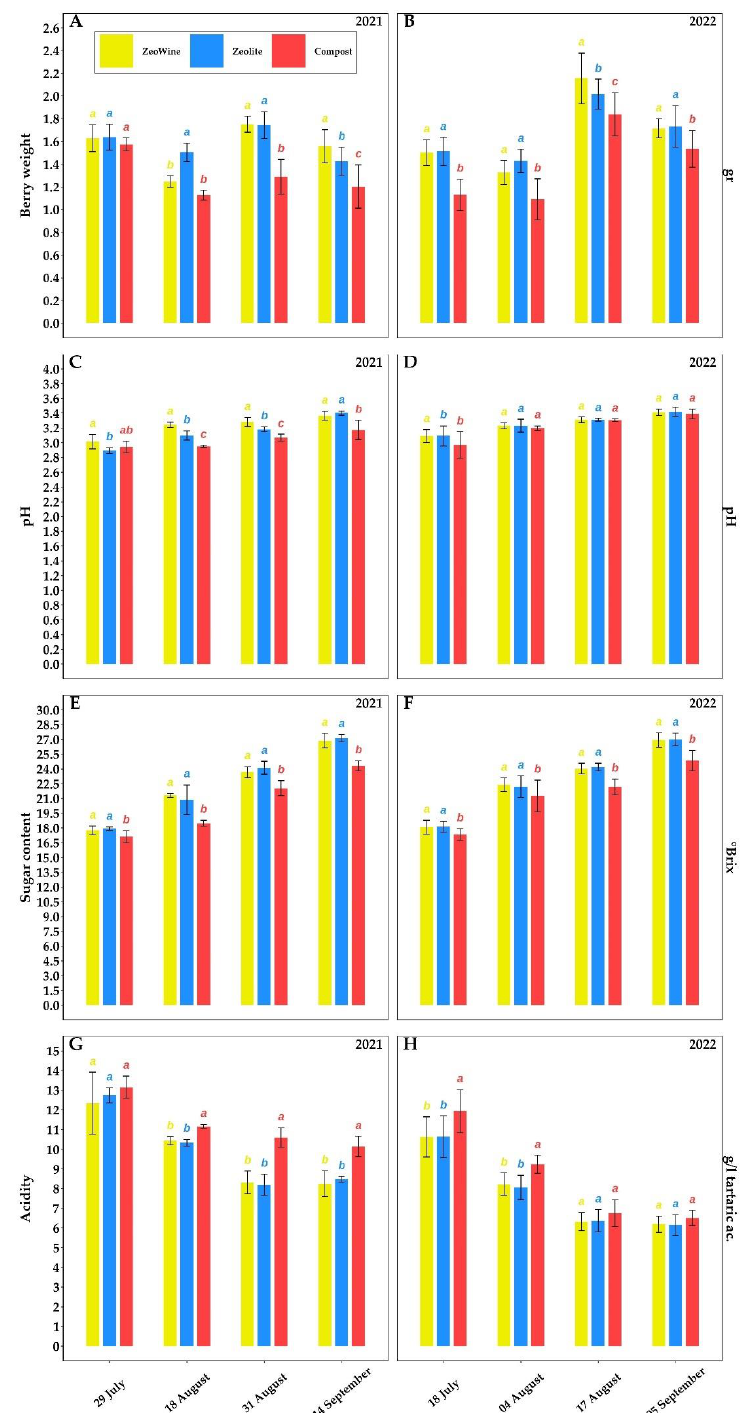
Figure 6. Technological maturity. Sugar content ( ◦ Brix), total acidity (TA), pH, and berry weight of Vitis vinifera treated with Zeowine, Zeolite, and Compost during two seasons (2021–2022, ( A )–( H